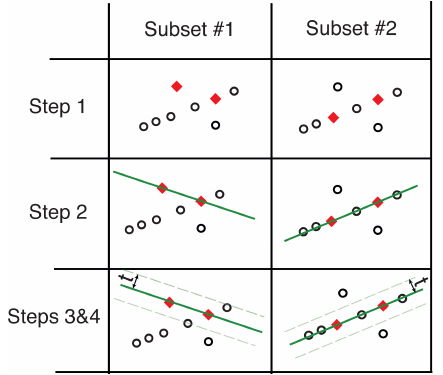
Figure 3. Visual representation of the functioning of RANSAC. Subset 1 and 2 represent two RANSAC iterations. The subset of measurements selected by RANSAC in each iteration is represented by red diamonds. Subset 1 contains one outlier. Hence, the solution corresponding with this subset generates fewer inliers than subset 2, which is free of